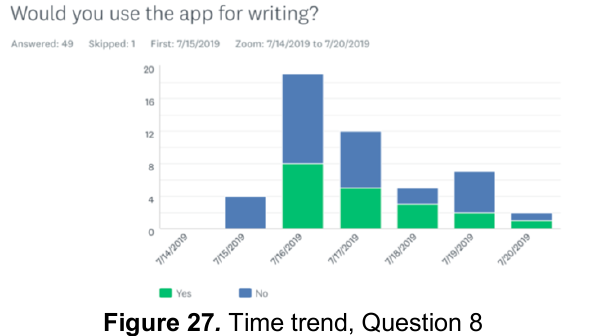
Figure 27 . Time trend, Question 8